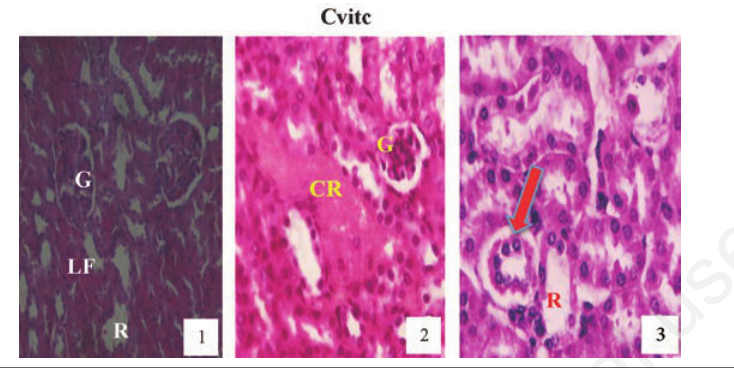
Figure 12. Hematoxylin and eosin staining after administration of 4 mg/kg of paraquat representing test subgroups maintained with vitamin C medicated drinking water (1 g/L) for a period of 3 months (original magnification 400X). The slide at month (1) is show- ing a picture of shrunken Bowman’s capsules and congested glomeruli (G) and leucocyte infiltrations (LF), progressing to renal vascular congestion (CR) and leucocyte infiltra- tions (LF) with shrunken glomeruli at month (2). At month (3) the picture indicated renal tubular (R) desquamated from the underlying basement membranes (arrow), inter- lobular vacuolation with glomerular (G) and tubular degeneration. Changes increased in an exposure time dependent manner but much better than Figure 10.